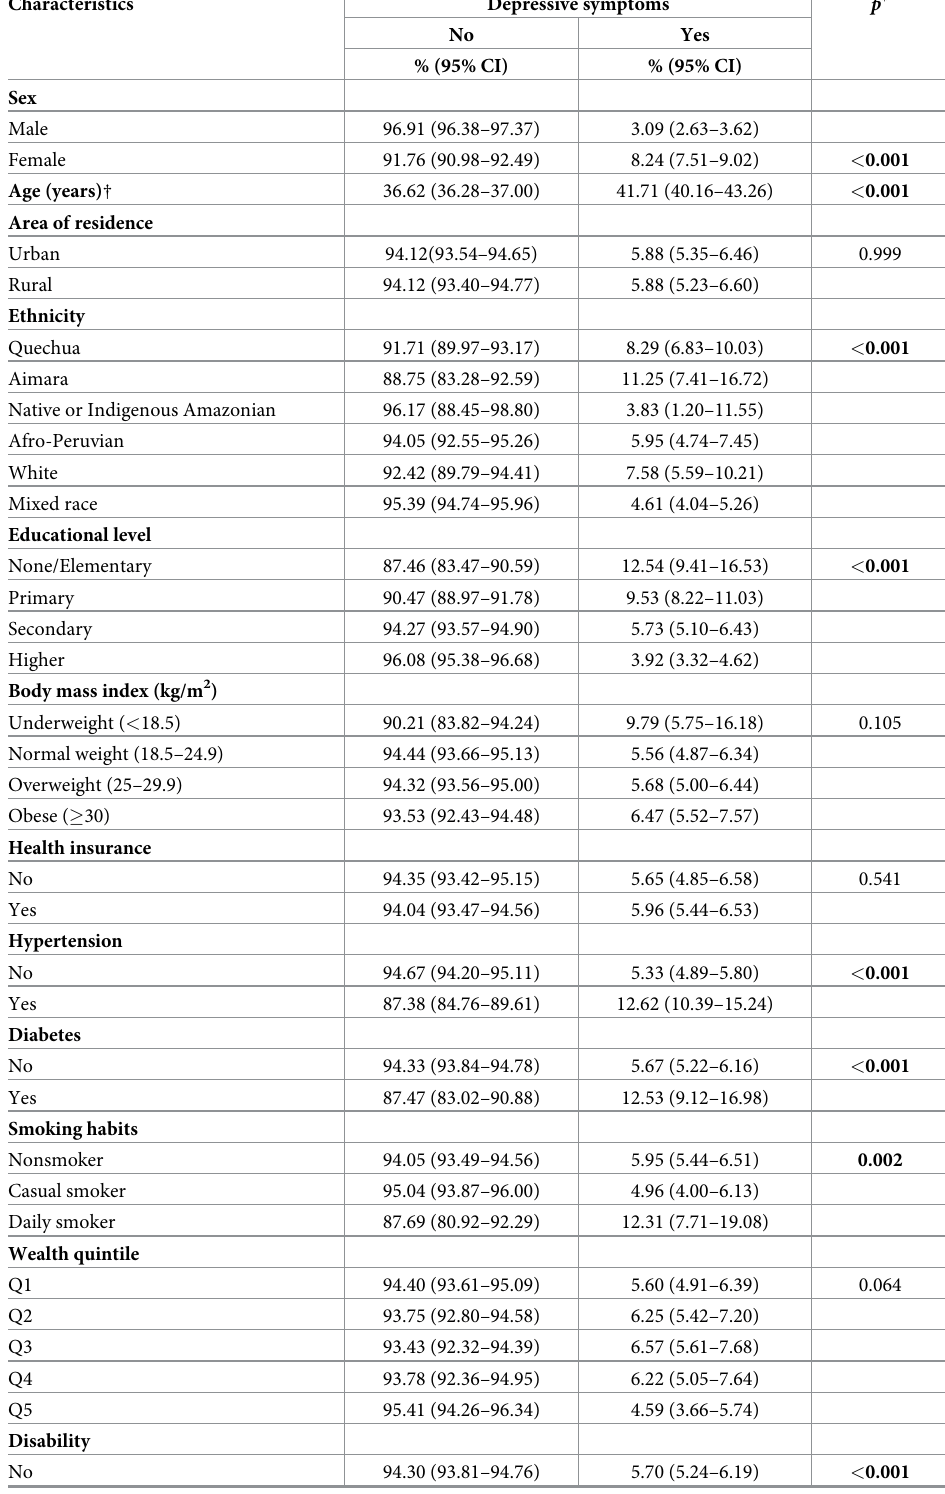
Table 2. Presence of depressive symptoms according to variables of